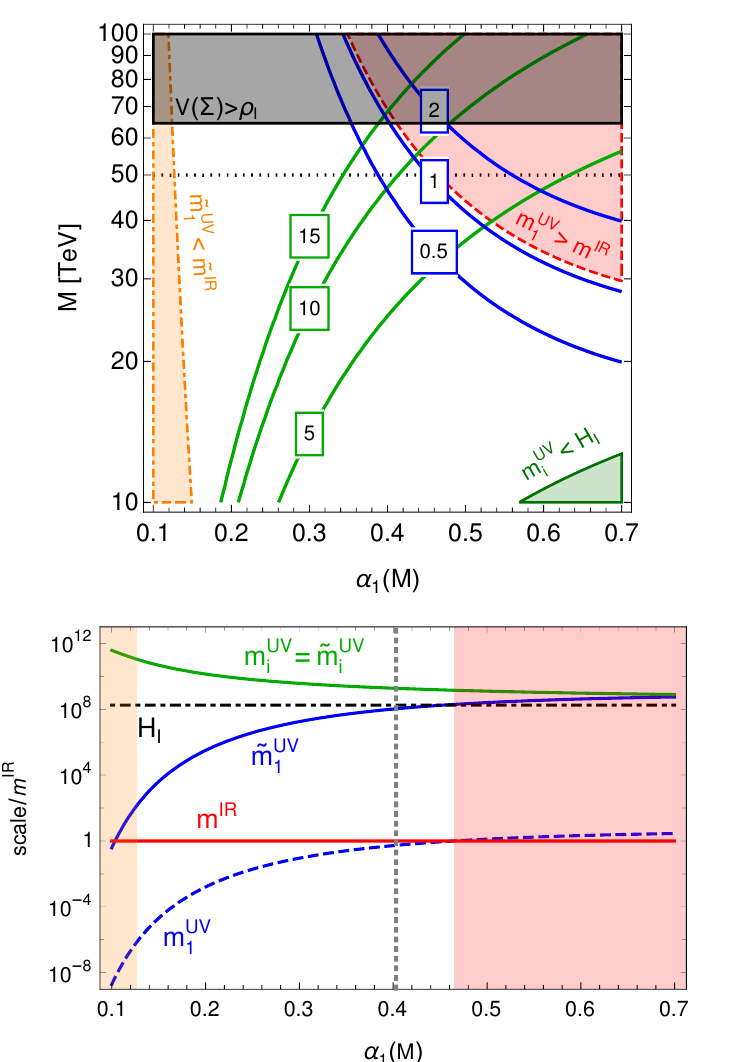
Figure 2 . Results of SU(3) 4 model, with PQ scale f a = 10 15 GeV, in(cid:13)ation scale H I = 1 eV, and chiral suppression ~ K 1 = 3 (cid:2) 10 (cid:0) 7 during in(cid:13)ation. We (cid:12)x (cid:11) 2 ( M ) = (cid:11) 3 ( M ) = (cid:11) 4 ( M ). Top: allowed (cid:11) 1 ( M ) (cid:0) M parameter space, after excluding those areas that do not satisfy the requirements of the model. The blue and green lines are are the curves of (cid:12)xed ~ m UV =H I and m UV =H I respectively. 1 i Bottom: the ratio of di(cid:11)erent mass/energy scales to the QCD axion mass m IR , with M = 50 TeV, which corresponds to the black dotted line of the top plot. The red and orange shaded areas are the same to those in the top plot: regions with m UV > m IR and ~ m 1 < ~ m IR respectively. The 1 vertical dotted gray line corresponds to the ~ m UV =H I = 0 : 6 benchmark, for which the a 1 axion’s 1 relic abundance is equal to the observed abundance of dark matter today. Note that the UV mass for axion with i 6 = 1 (green line) does not change during and after in(cid:13)ation.